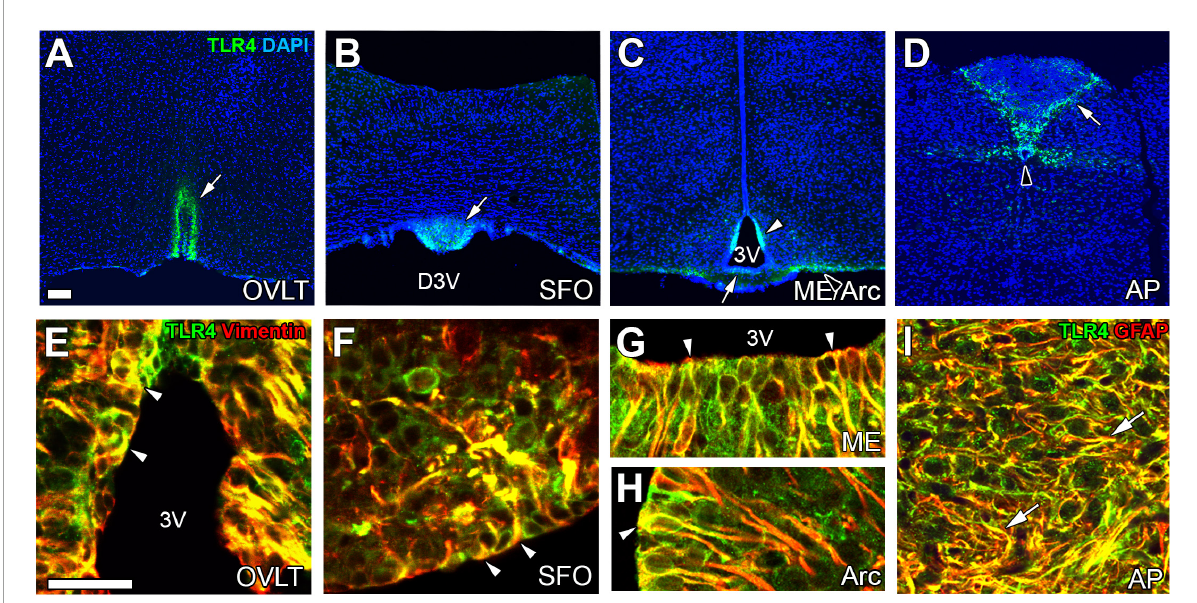
FIGURE4 The expression of TLR4 at astrocytes/tanycytes of the adult mouse brain. Immunohistochemistry shows robust and specific TLR4 expression in the CVOs (open arrows), Arc (open arrowhead), and CC (solid arrowhead) (A–D) . Double-labeling immunohistochemistry reveals that TLR4 is expressed at vimentin + tanycytes (arrowheads) and GFAP + astrocytes (arrows) (E–I) . Scale bars = 50 µ m. 3V, 3rd ventricle; AP, area postrema; Arc, arcuate nucleus; DAPI, 4 (cid:48) ,6-diamidino-2-phenylindole; D3V, dorsal 3rd ventricle; GFAP, glial fibrillar acidic protein; ME, median eminence; OVLT, organum vasculosum of the lamina terminalis; SFO, subfornical organ; TLR4, toll-like receptor 4. Photographs are rearranged with permission from Elsevier B.V. (Muneoka et al.,